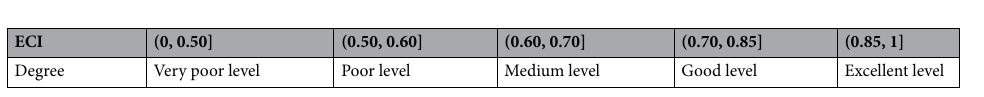
Table 3. Classification standard for emergency capacity of rain-flood disaster. ECI emergency capacity